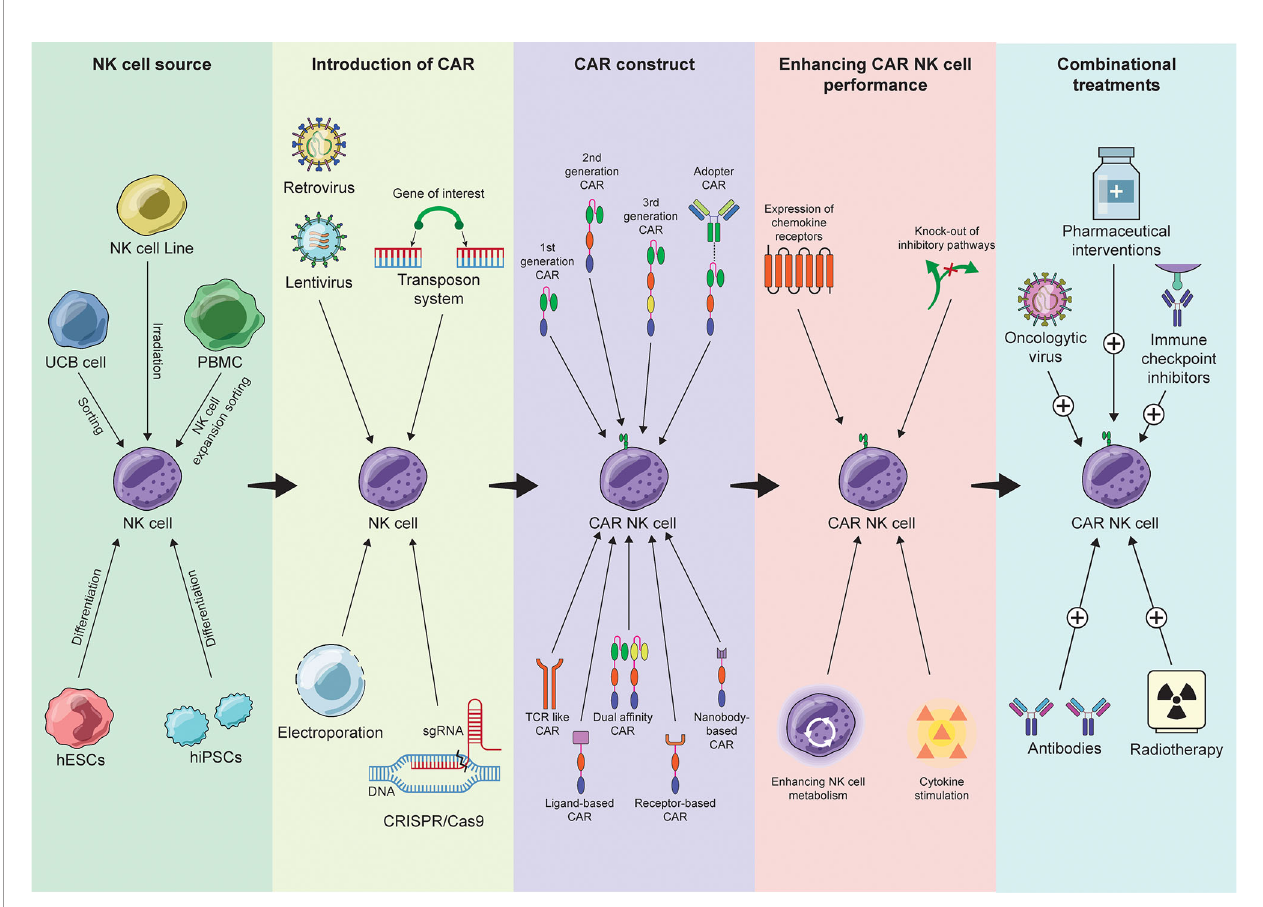
FIGURE 1 | Summary of the recent advances in the process of CAR-NK cell therapy development from NK cell source selection to combinational